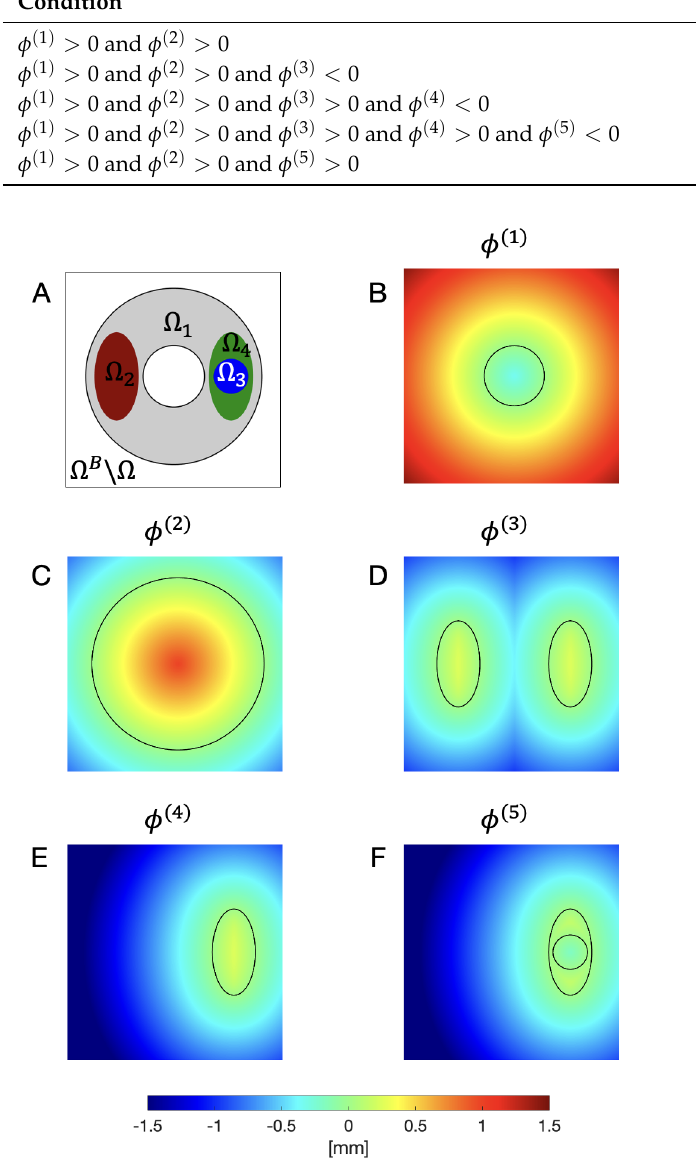
Table 1. Level set-based criteria to classify a point x in Ω and its subdomains. Condition Classification